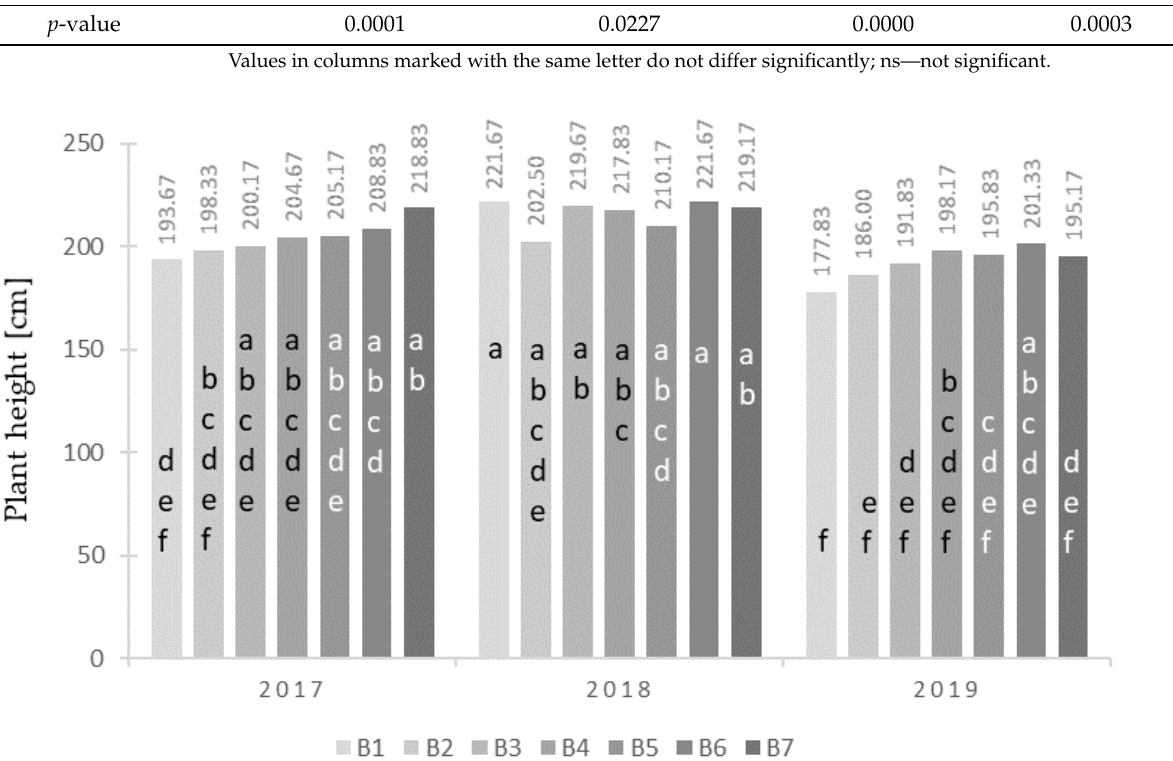
Table 4. Average values of morphological features of maize plants for cultivars (A) and fertilizer